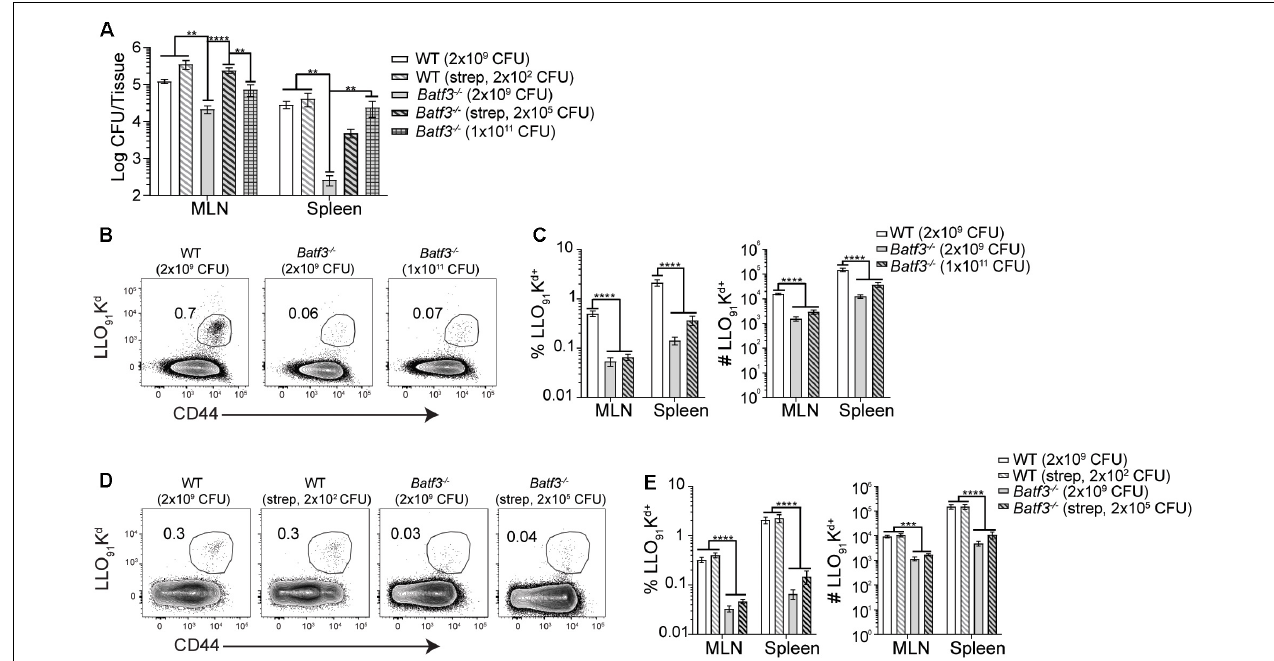
FIGURE 7 | Induction of CD8 T cell responses are not rescued by restoring pathogen load. 20 mg of streptomycin was administered to the indicated groups of WT and Batf3 − / − Balb/c mice 1 day prior to infection. Mice were infected with the indicated doses of InlA M Lm 10403s. (A) At 3 dpi, MLN and spleens were harvested, processed, and plated on BHI agar to enumerate InlA M Lm burden. Data are pooled from 5 to 6 individual experiments and included both male and female mice ( n = 7–41). (B–E) At 9 dpi, MLN and spleens were harvested and processed for flow cytometry. LLO 91 -K d tetramer staining was utilized to analyze InlA M Lm -specific CD8 T cell responses. Data are pooled from 4 to 6 individual experiments and included both male and female mice ( n = 12–20 mice per group). (B,D) Representative tetramer staining is shown. Bacterial burdens were compared using one-way ANOVA with Kruskal-Wallis non-parametric test. Cell populations were compared using one-way ANOVA with Bonferroni’s multiple comparisons test: ** p < 0.01; *** p < 0.001; **** p <